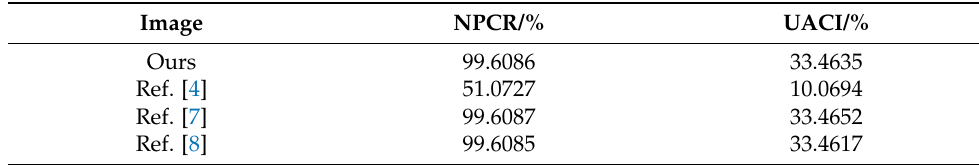
Table 6. Differential attack test results.